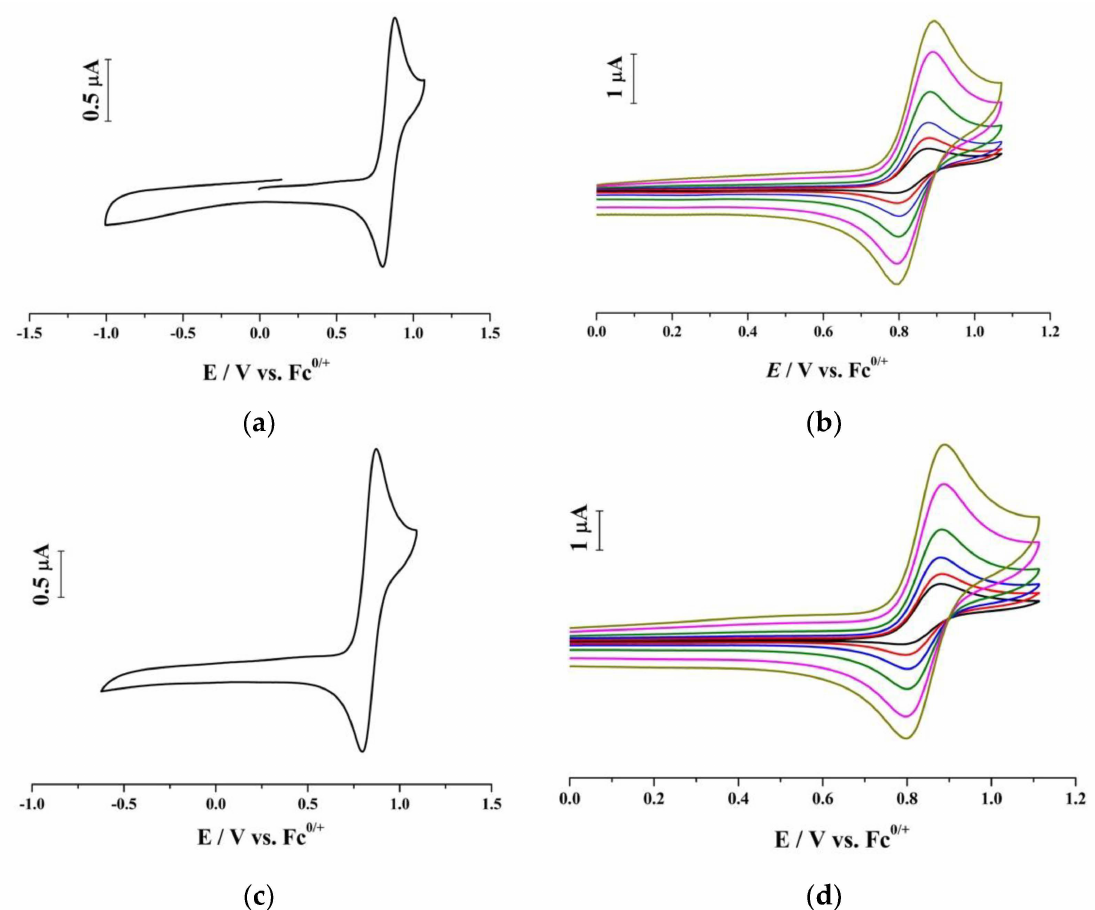
Figure 3. Cyclic voltammograms obtained for 5 mM 1 in ( a , b ) [bmpyr][NTf 2 ], ( c , d ) [emim][NTf 2 ] at a glassy carbon electrode (d = 1 mm). ( a – c ) over a wide potential range with a scan rate of 0.1 V s − 1 and ( b – d ) over the potential region where the oxidation occurs at scan rates of 0.02, 0.05, 0.10, 0.20, 0.40, and 0.60 V s − 1 . T = 21 ± 1 ◦